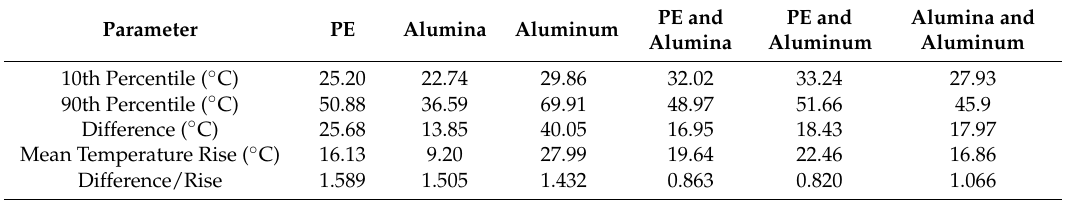
Table 3. Non-uniformity, as calculated using 10th and 90th percentiles (see text for definition) with 2919 mesh dots, in potato temperature distribution after 12 s heating with a turntable composed of multiple materials or a single